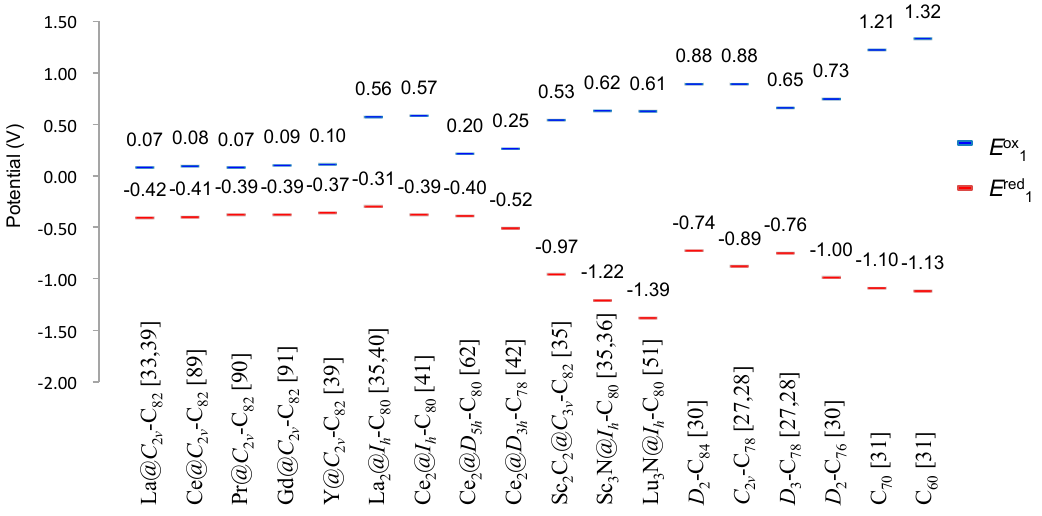
Figure 2. Redox potentials of EMFs and empty fullerenes. Values are in V relative to the ferrocene/ferrocenium couple (Fc/Fc + ).